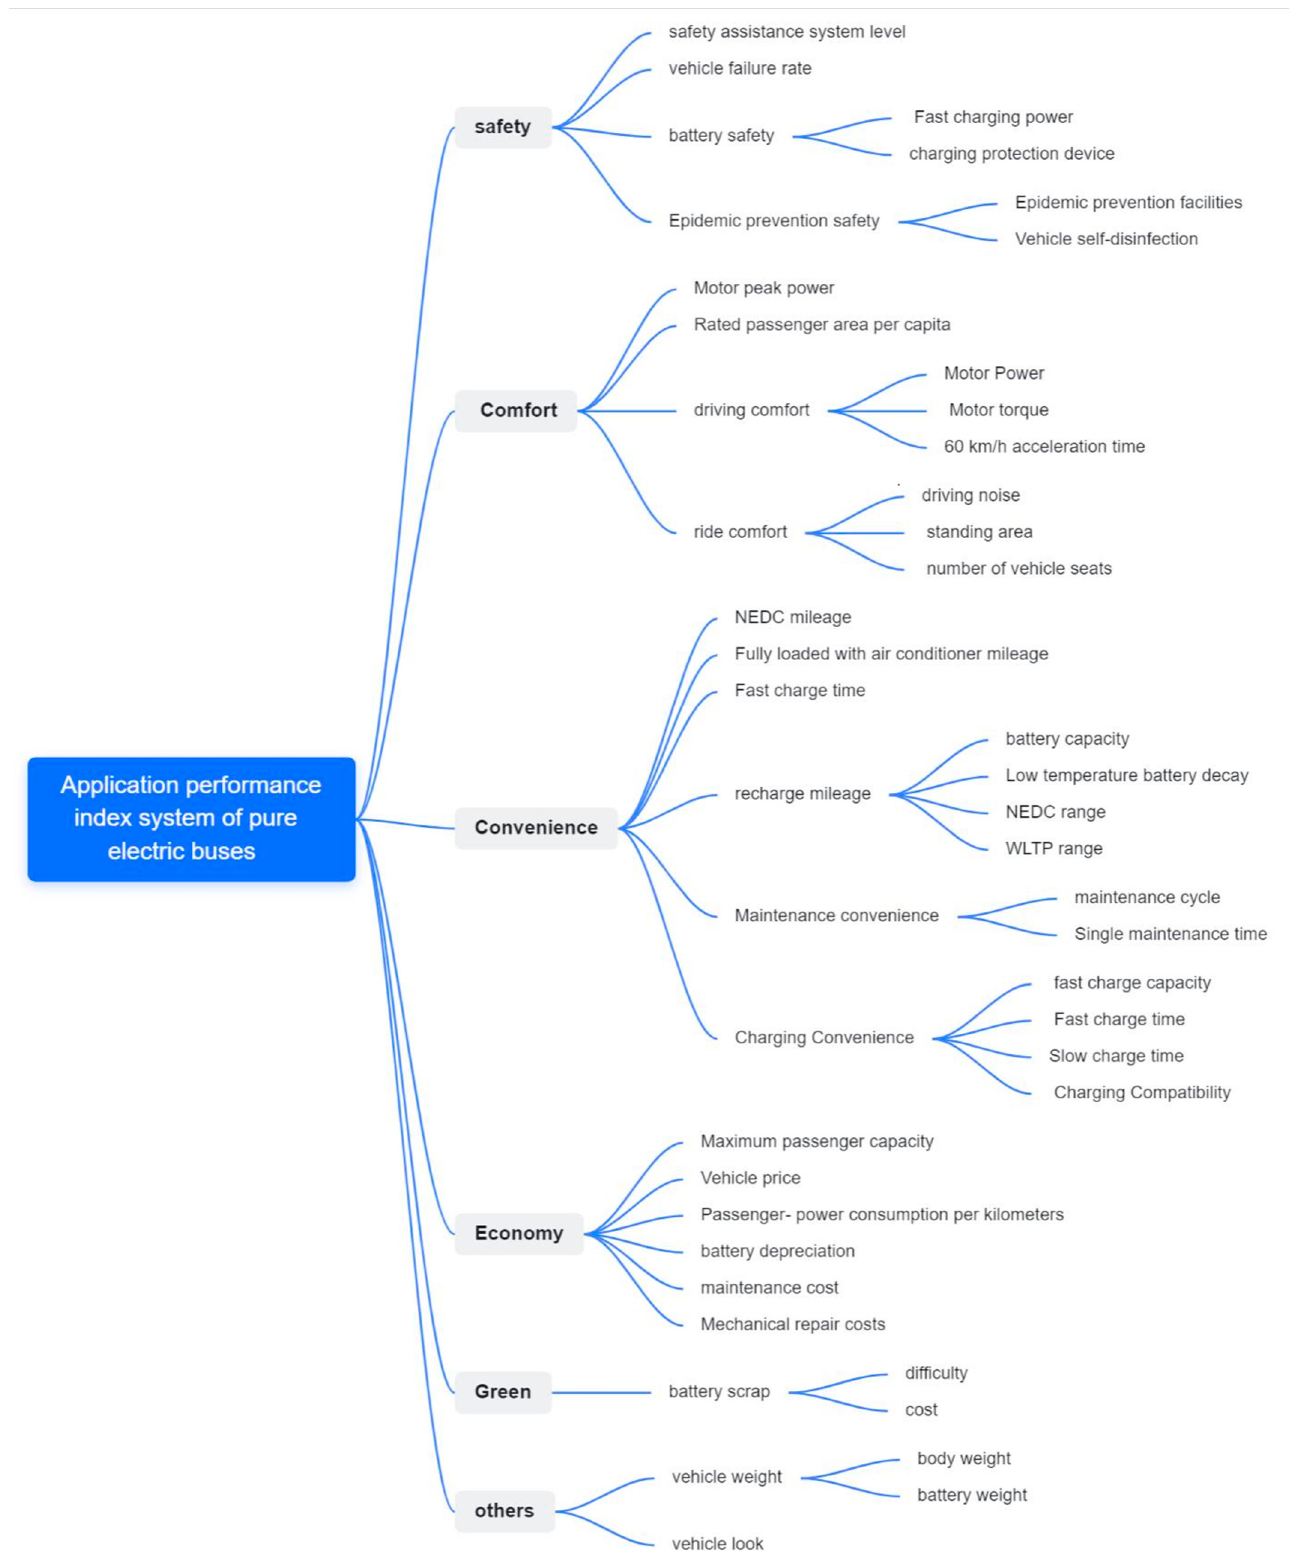
Figure 1. The initial application performance index system of pure electric buses. The standard level of the indicator system includes six aspects of safety, comfort, convenience, economy, green, and others, involving more than 40 specific indicator items.